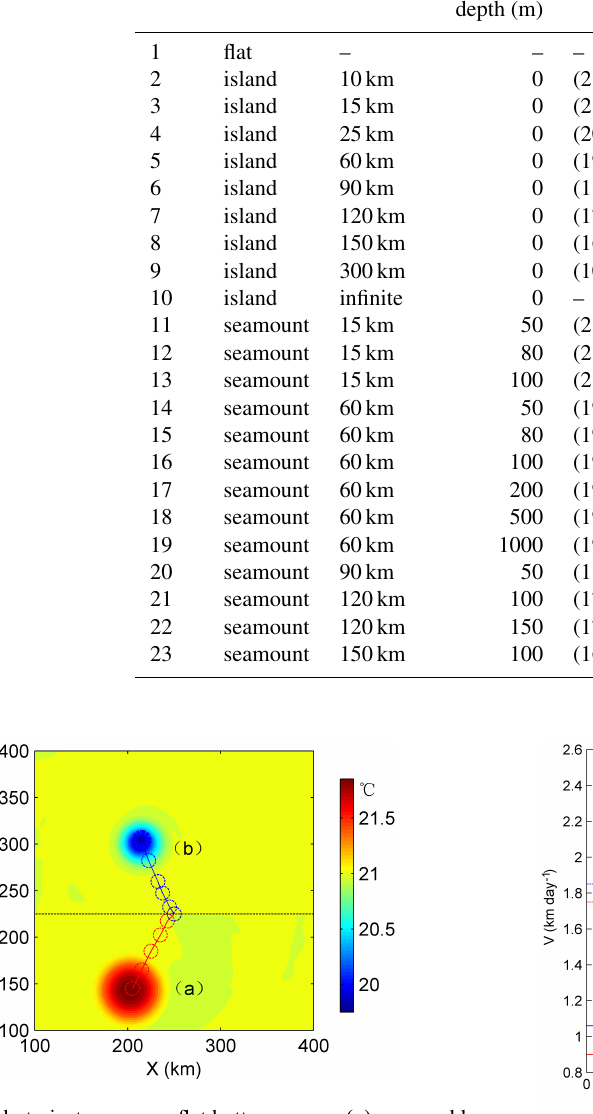
Figure 3. The speed of eddies over a flat bottom ocean. Solid lines: time series of speed; dashed lines: the speed averaged over 50